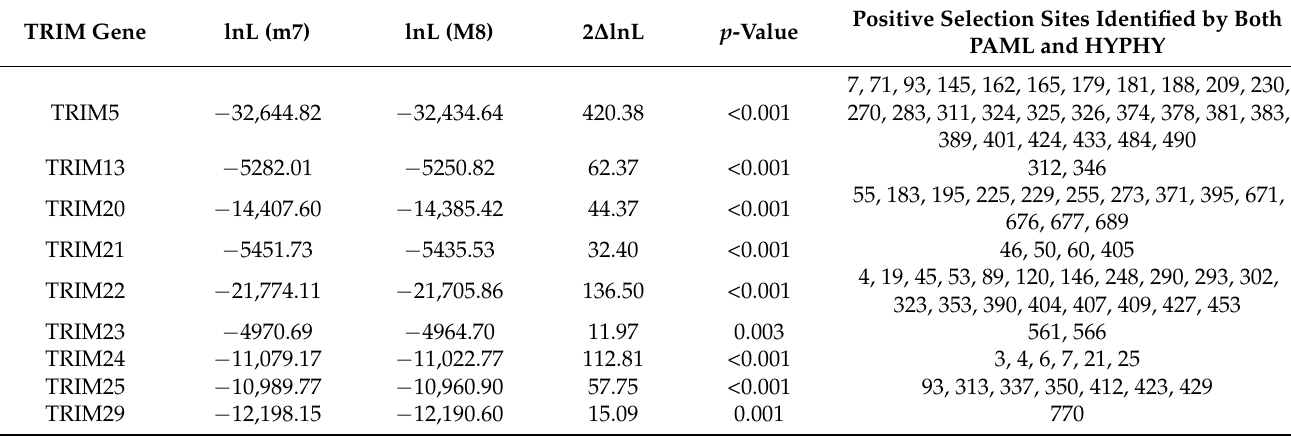
Figure 2. Phylogeny and motif composition of TRIM family proteins of Myotis lucifugus . The phylogeny tree was constructed by FastTree, and the motif composition was analyzed by MEME. Table 2. Bat TRIM genes evolving under positive